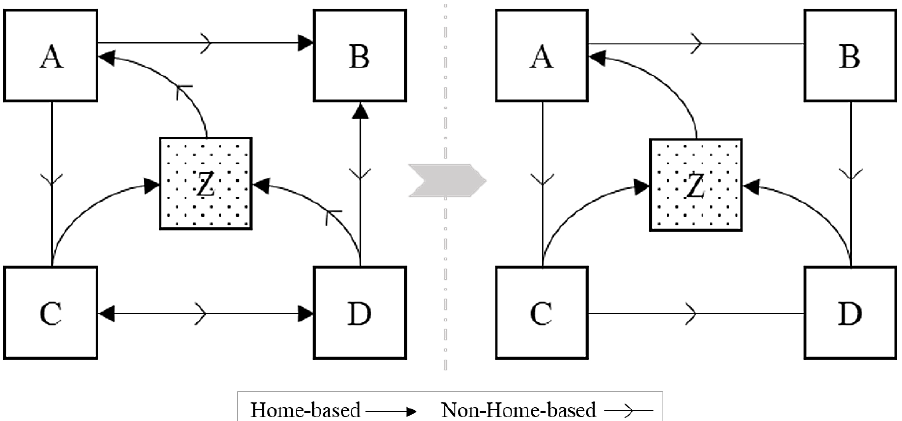
Network filtering to ensure that only Home-Based zone-sequences originating from Z can be